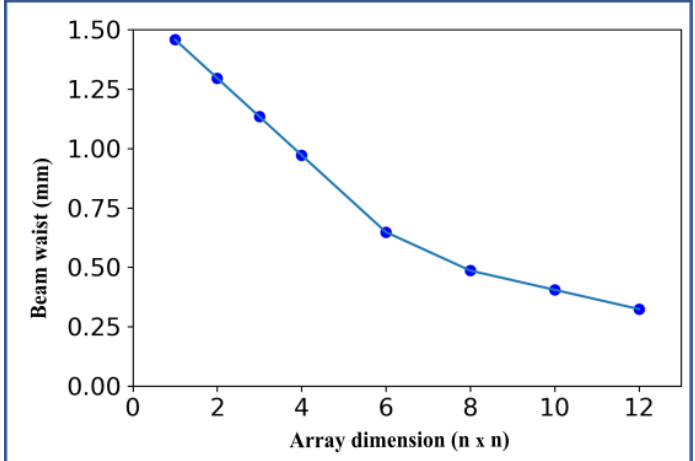
Figure 4. Variation of beam waist of the individual beam of an array with the size of the array (n ×